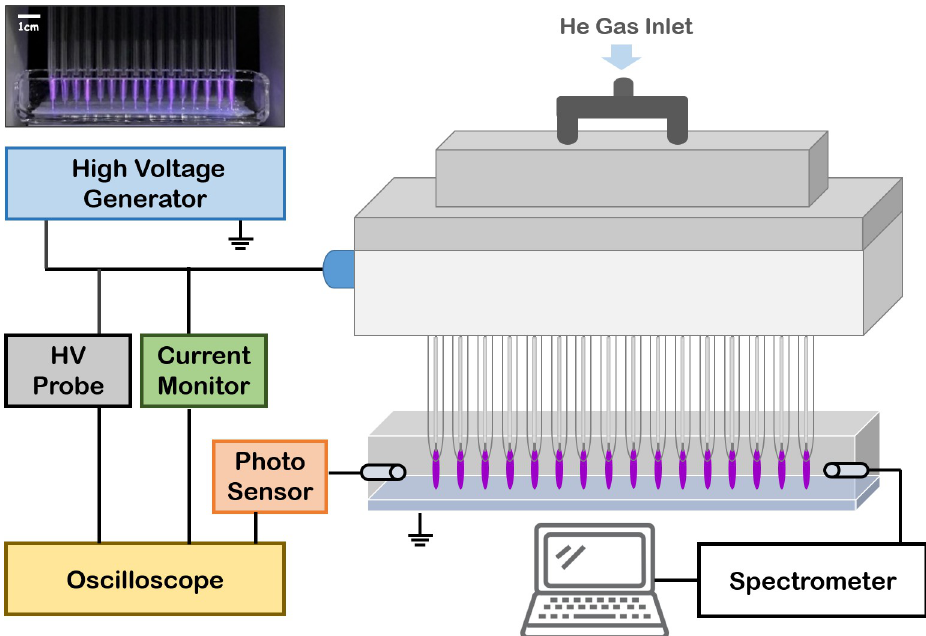
Fig 1. (a) Photograph of the plasma plumes from the jet array contacting a medium in a liquid container, and (b) the schematic of the experimental